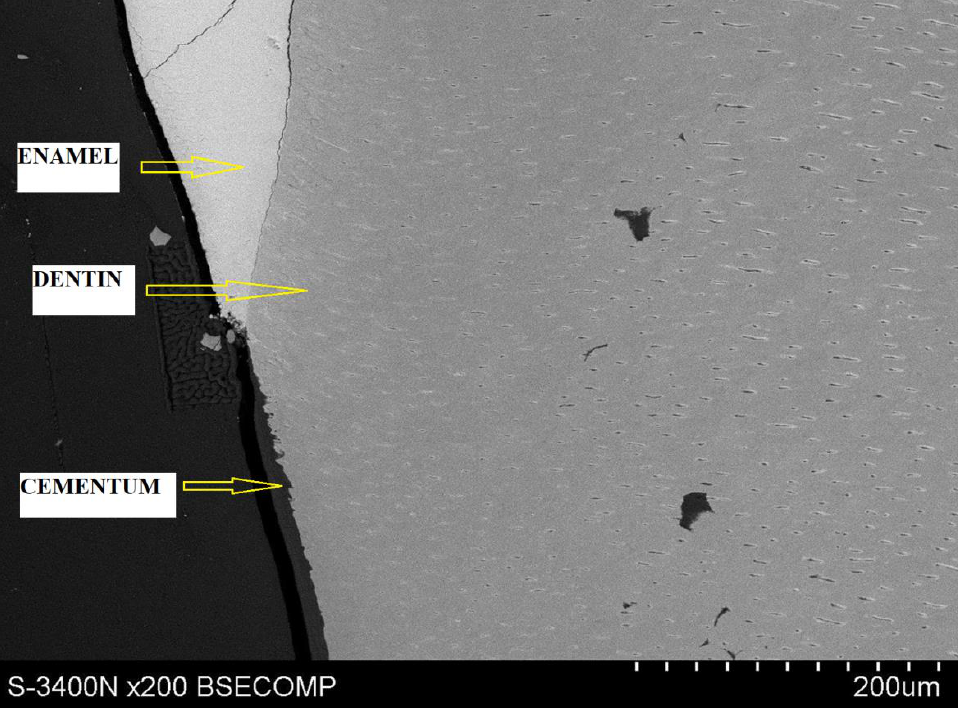
Figure 3. A photograph showing anatomical tooth structures. With the use of a scanning microscope, the thickness of root cement in the cervical region was determined to be 7.47 µm, as shown in Figure 4. It was also possible to see the expansion of root cement, with an increasing thickness to 55.6 µm towards the root apex, as shown in Figure 5.